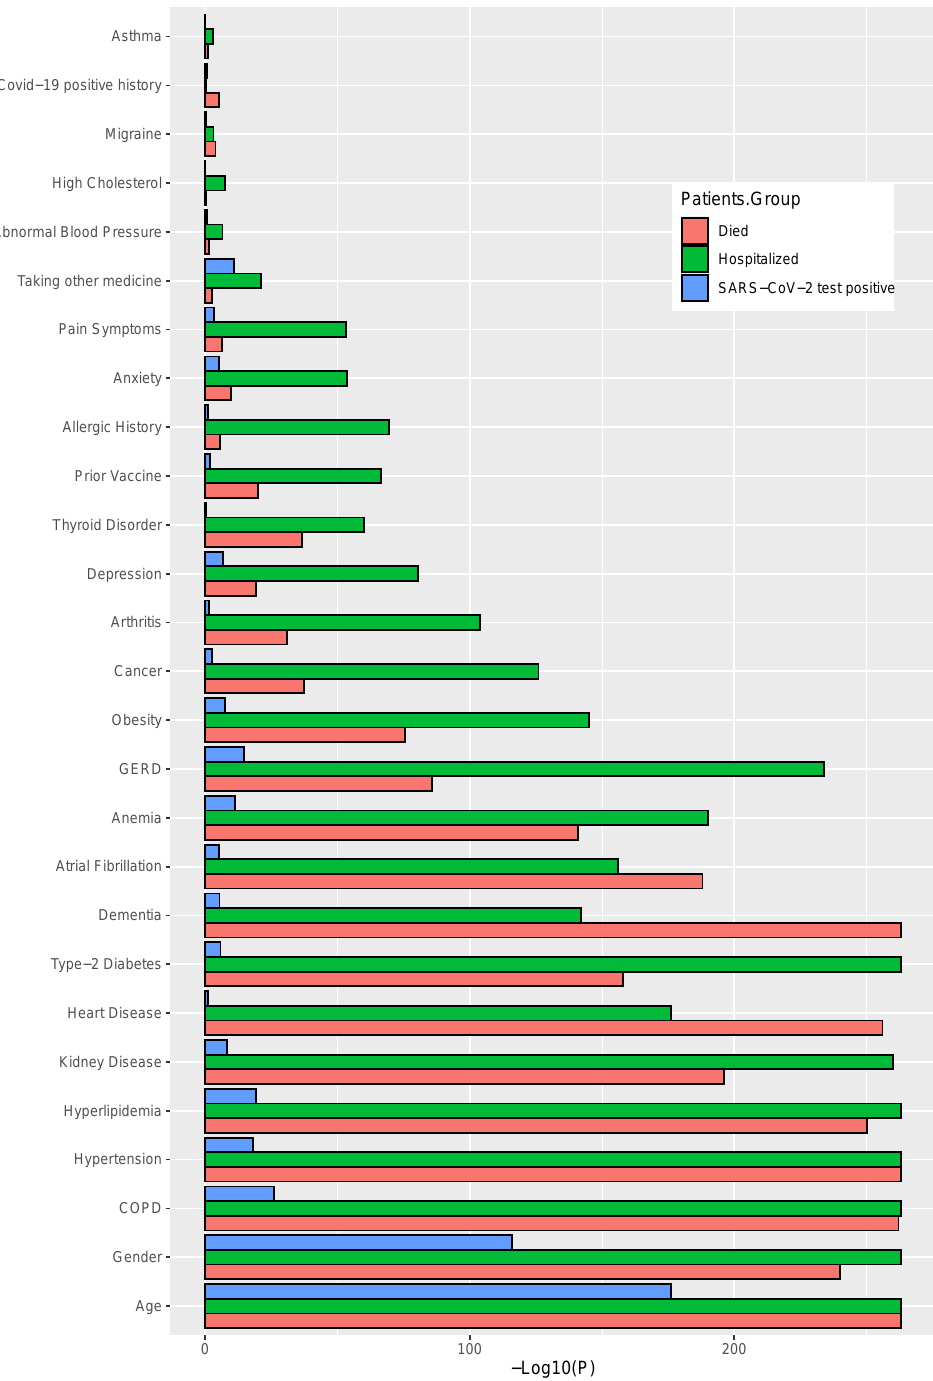
Figure 4. The significant features within the patients’ medical history, where the higher bar length indicates greater the